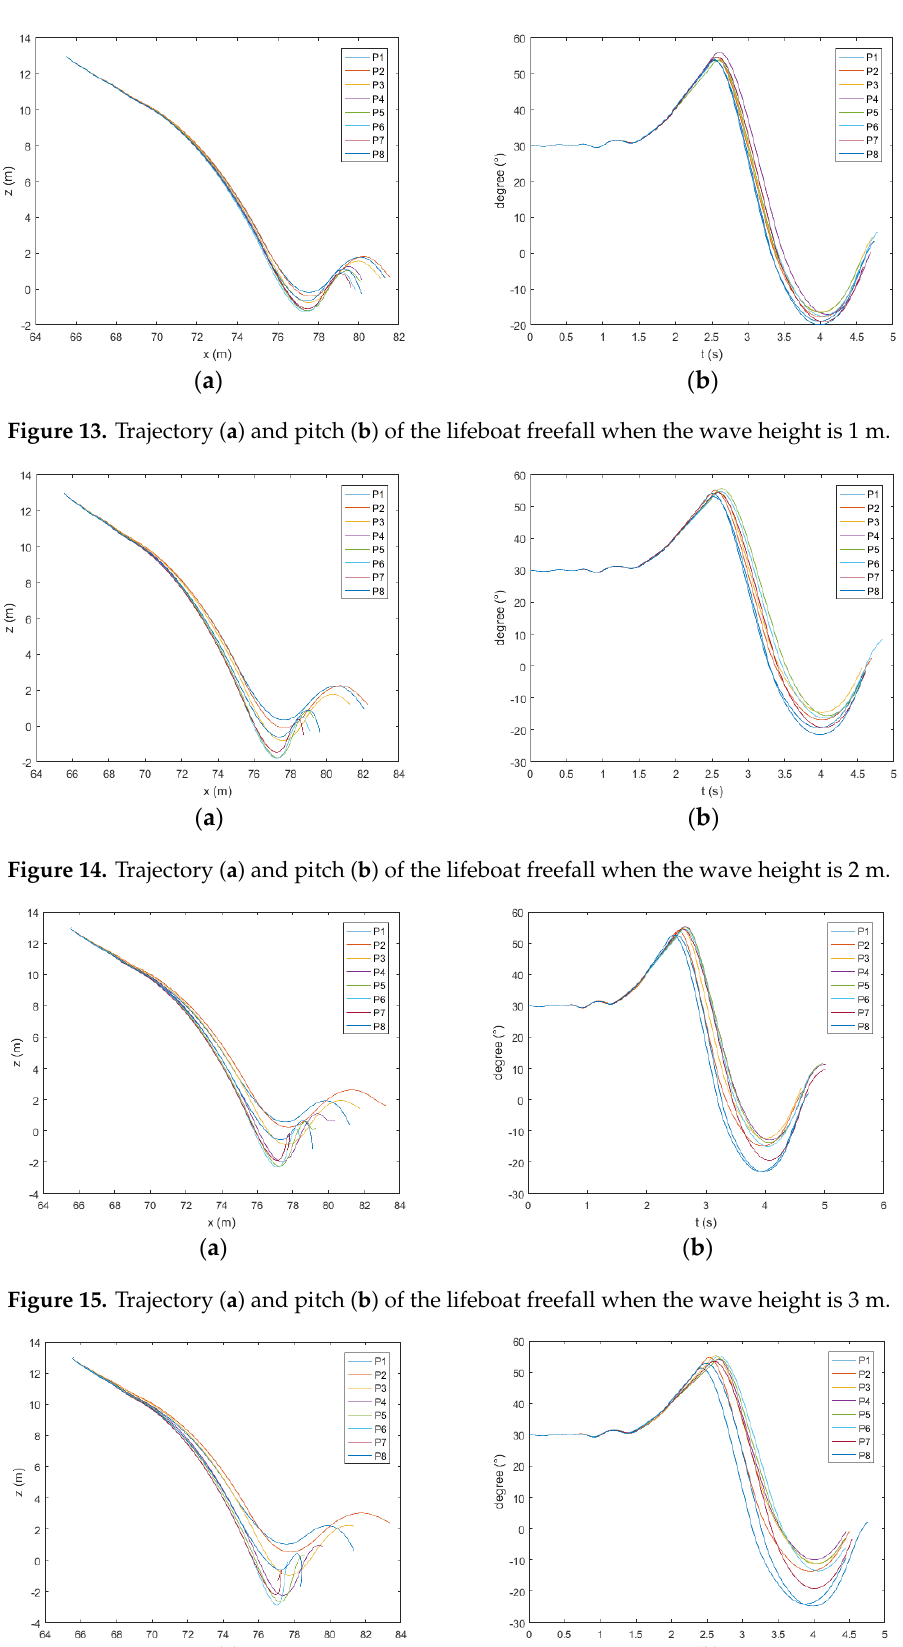
( b ) Figure 12. Eight different points of water entry of the boat when the ship is heading the wave ( a ) and following the wave ( b ). Figures 13‒17 show the trajectory and pitch angle of the lifeboat when the ship is heading the wave. Figure 18 shows the maximum value of the acceleration in the directions of 𝑏 1 and 𝑏 3 at the bow (Figure 18a,b), midship (Figure 18c,d), and stern (Figure 18e,f) of the boat at eight different points of water entry when the ship is heading waves. Figures 19‒23 show the trajectory and pitch angle of the lifeboat when the ship is following waves. Figure 24 shows the maximum value of the acceleration in the directions of 𝑏 1 and 𝑏 3 at the bow (Figure 24a,b), midship (Figure 24c,d), and stern (Figure 24e,f) of the boat at eight different points of water entry when the ship is following waves. As there are no experimental data for comparison, the numerical calculation results may not be very accurate, but can be used in a qualitative analysis. The ship heads the wave. As shown in Figures 15‒17a, when the wave height exceeds 3 m, the boat will move to the side of the ship after water entry at P7 and P8. As shown in Figures 16a and 17a, when the wave height exceeds 4 m, the same phenomenon appears at point P6. As shown in Figures 13‒17b, at points P1 and P8, the pitch angle of the boat has a large range of change. As shown in Figure 18, in the direction of 𝑏 1 , the maximum values of acceleration at the bow, midship, and stern of the boat appear at point P4; the minimum value generally appears at P1 and P8. The